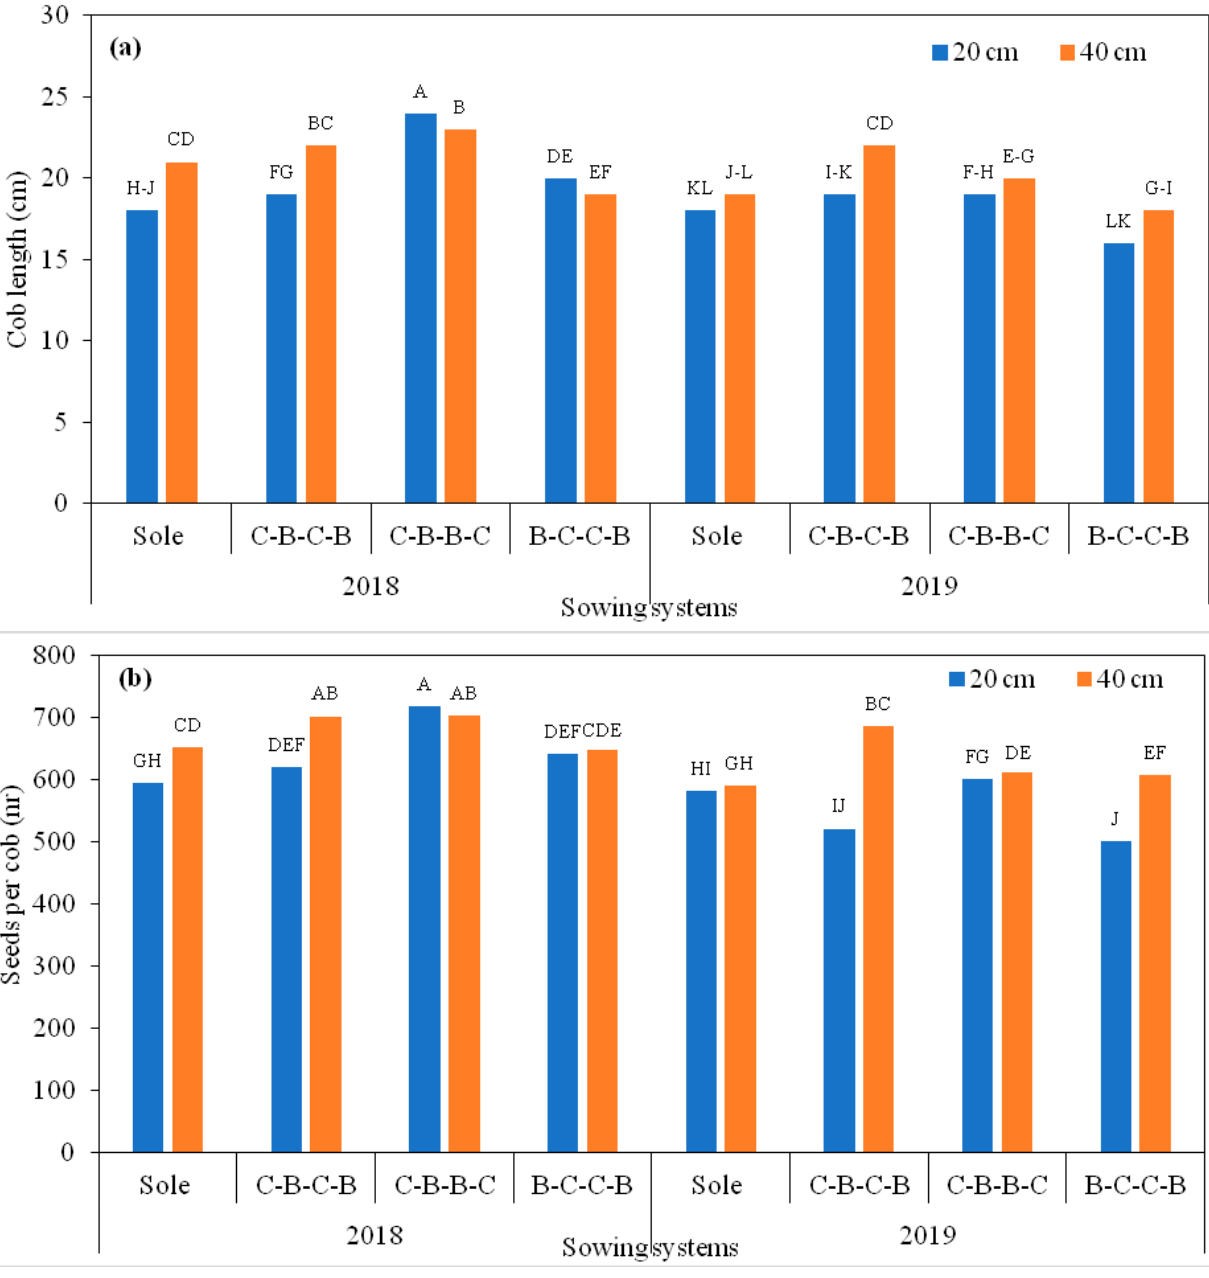
Figure 3. The interactions of maize–white bean sowing systems on cob length ( a ) and seeds per cob ( b ) at Nur Sultan, Kazakhstan research station. Letters on each bar represent a significance level at p < 0.01. Note: different letters denote significant differences, while the same letters indicate insignificantly different values.